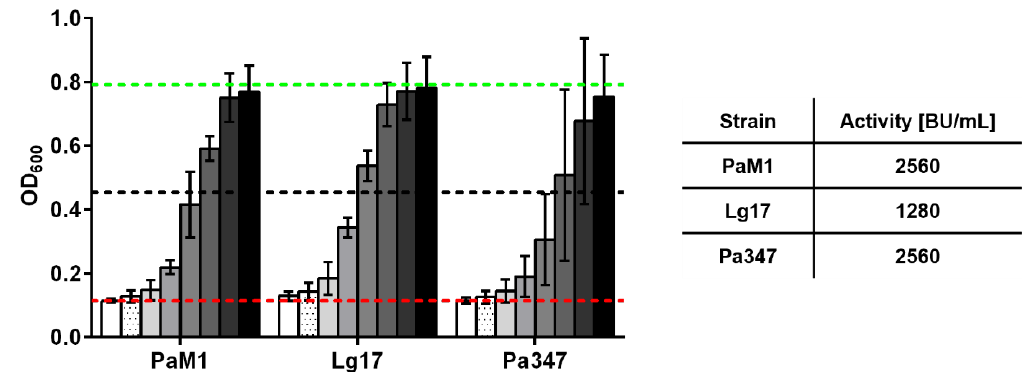
Figure 2. Inhibition of growth of L. monocytogenes EGDe/pNZ-P help -pHluorin by 2-fold serial dilutions (1:8–1:1024, indicated by a white-black scale) of supernatants of LAB isolates P. acidilactici M1 (PaM1), E. faecium M4 (EfM4), L. garvieae 17 (Lg17), and L. lactis 18 (Ll18) or P. acidilactici 347 (Pa347). Bacteria were grown o/N in 5 mL MRS medium in glass tubes. Values are OD 600 of the indicator strain ± SD of n = 4 independent experiments. The broken red and green lines indicate OD 600 of the positive (i.e., complete inhibition of growth) or negative (i.e., sterile MRS medium) controls, respectively. The broken black lines represent growth inhibition of 50% (i.e., the threshold to calculate bacteriocin units).